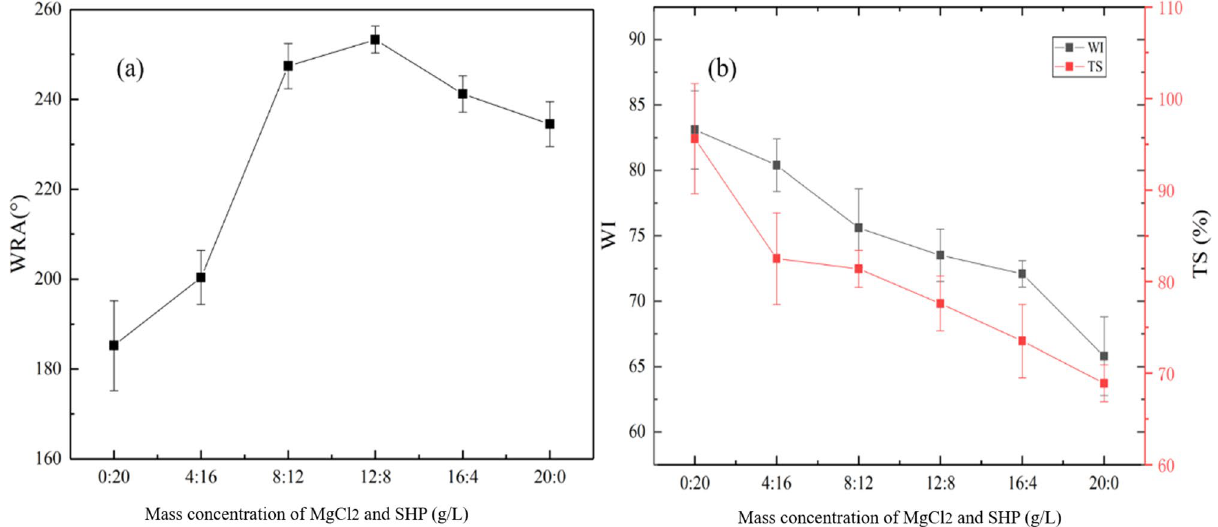
Figure 4. The effects of different mass concentration ratios for MgCl 2 and SHP, on the WRA ( a ), WI and TS ( b ) of the finished fabrics.